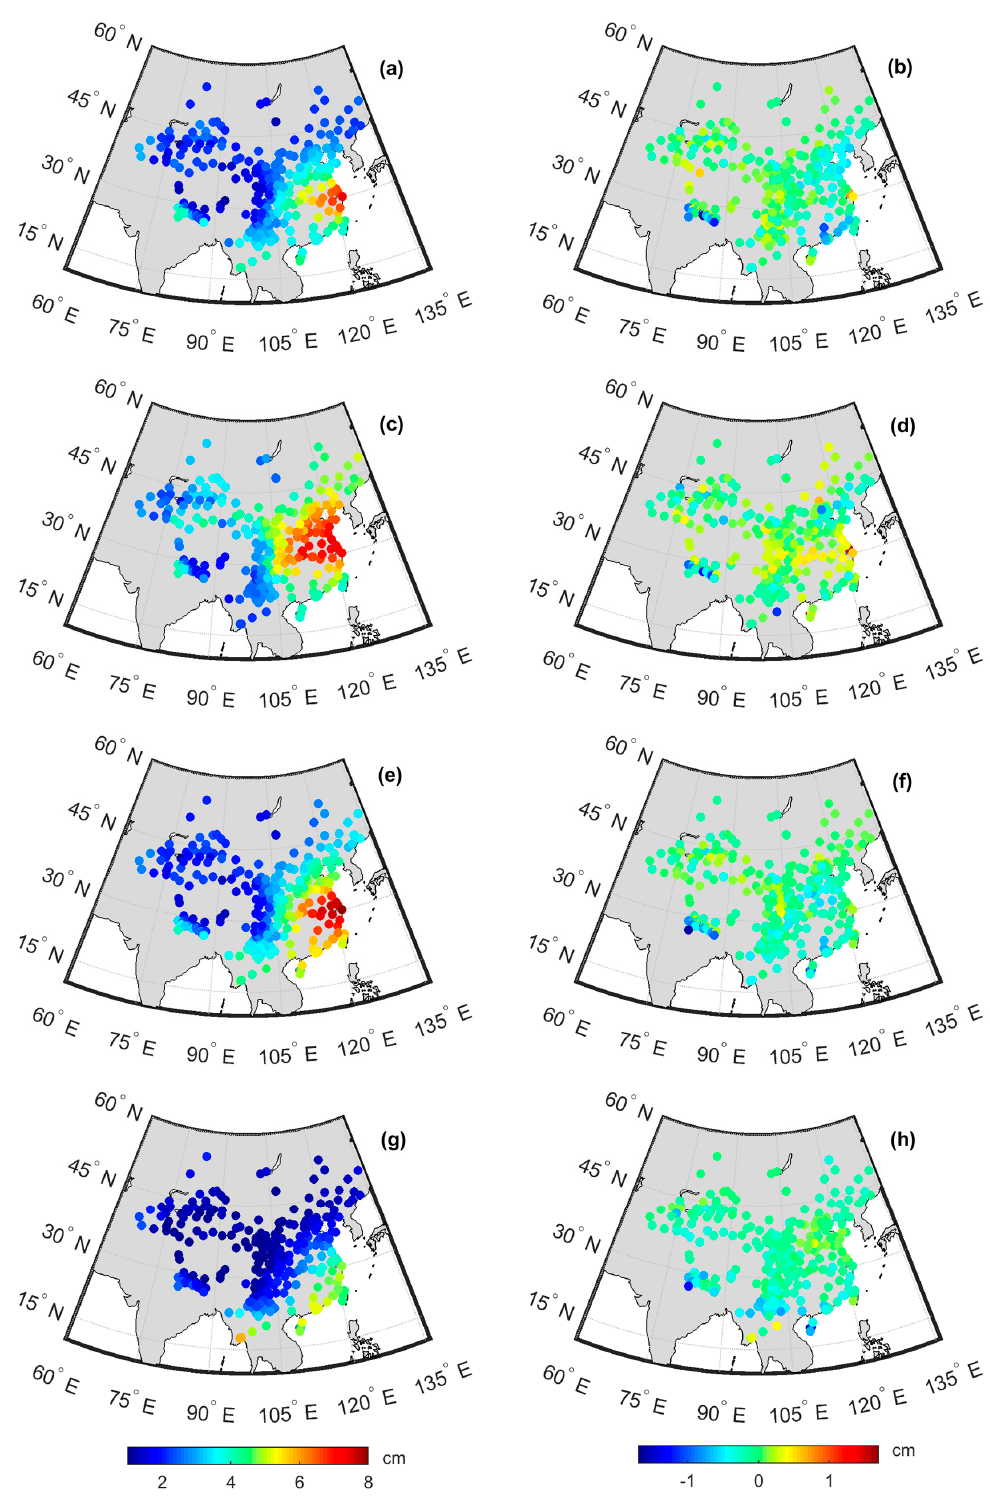
Figure 9. Left: predicted ZTD uncertainty of SHAtropE during the period of 2012–2018 in different seasons: ( a ) Mar-Apr-May, ( c ) Jun-Jul-Aug, ( e ) Sep-Oct-Nov, and ( g ) Dec-Jan-Feb; Right: the difference between predicted uncertainty of SHAtropE and the RMS value of SHAtropE ZTD w.r.t. RAW ZTD during the period of 2012–2018 for different seasons: ( b ) Mar-Apr-May, ( d ) Jun-Jul-Aug, ( f ) Sep-Oct-Nov, and ( h ) Dec-Jan-Feb.